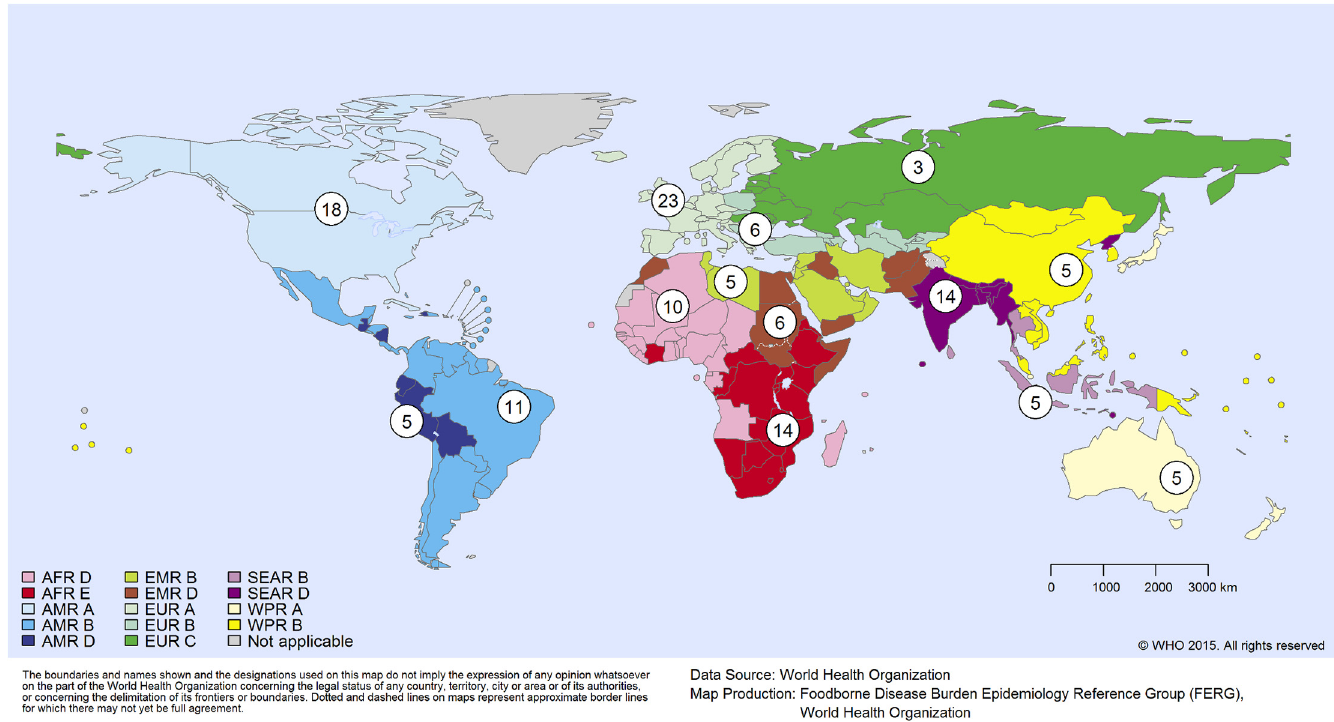
Fig 1. Geographical distribution of the number of experts per subregion according to working experience ( > 3 years). Several experts had experience in more than one subregion. The subregions are defined on the basis of child and adult mortality as described by Ezzati et al. [63]. Stratum A: very low child and adult mortality, Stratum B: low child mortality and very low adult mortality, Stratum C: low child mortality and high adult mortality, Stratum D: high child and adult mortality, and Stratum E: high child mortality and very high adult mortality. AFR = African Region; AMR = Region of the Americas; EMR = Eastern Mediterranean Region; EUR = European Region; SEAR = South-East Asia Region; WPR = Western Pacific Region. A list of countries per subregions can be found in Havelaar et al. (48). The use of the term ‘ subregion ’ here and throughout the text does not identify an official grouping of WHO Member States, and the ‘ subregions ’ are not related to the six official WHO